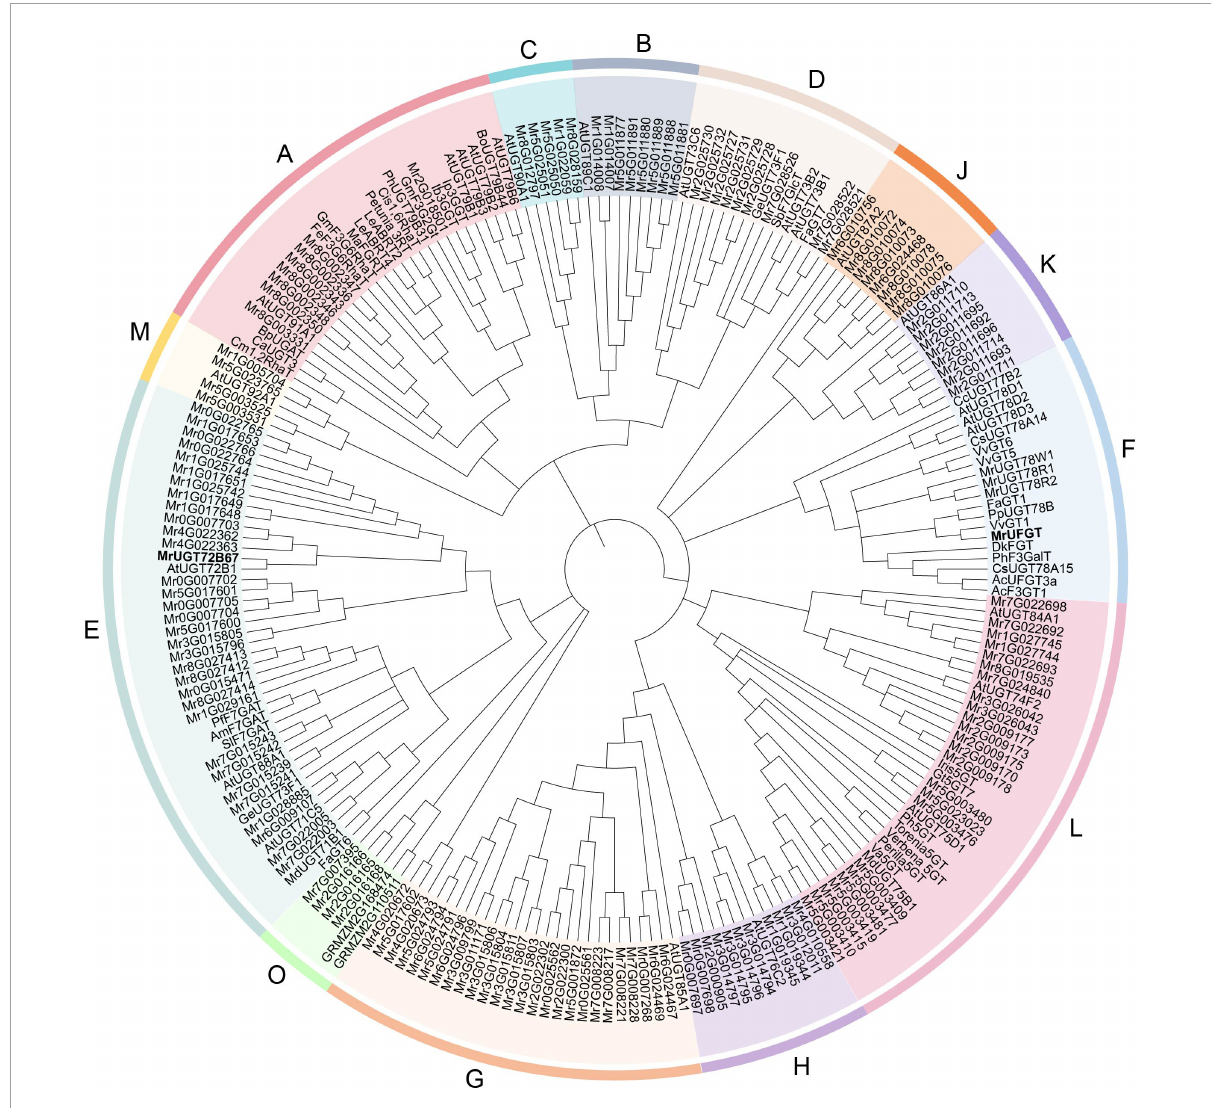
FIGURE1 Phylogenetic analysis of Morella rubra UDP-glycosyltransferase (UGT) gene family. Phylogenetic tree was constructed by neighbor-joining method. Groups are shown in different colors. Abbreviations of species names are follows: AC, Aralia cordata ; Am, Antirrhinum majus ; At, Arabidopsis thaliana ; Bo, Brassica oleracea ; Bp, Bellis perennis ; Ca, Catharanthus roseus ; Cc, Crocosmia × crocosmiiflora ; Cm, Citrus maxima ; Cis, Citrus sinensis ; Cs, Camellia sinensis ; Dk, Diospyros kaki ; Fa, Fragaria × ananassa ; Fe, Fagopyrum esculentum ; Ge, Glycyrrhiza echinata ; Gm, Glycine max ; Gt, Gentiana triflora ; Iris, Iris hollandica ; Ib, Ipomoea batatas ; Ip, Ipomoea nil ; Le, Lobelia erinus ; Ma, Morus alba ; Md, Malus × domestica ; Perilla, Perilla frutescens ; Ph, Petunia hybrida ; Pf, Perilla frutescens ; Pp, Prunus persica ; Sb, Scutellaria baicalensis ; Sl, Scutellaria laeteviolacea ; Torenia, Torenia hybrid ; Va, Vitis amurensis ; Verbena, Verbena hybrida ; Vv, Vitis vinifera . Accession numbers of UGTs from other species are shown in Supplementary Table 1